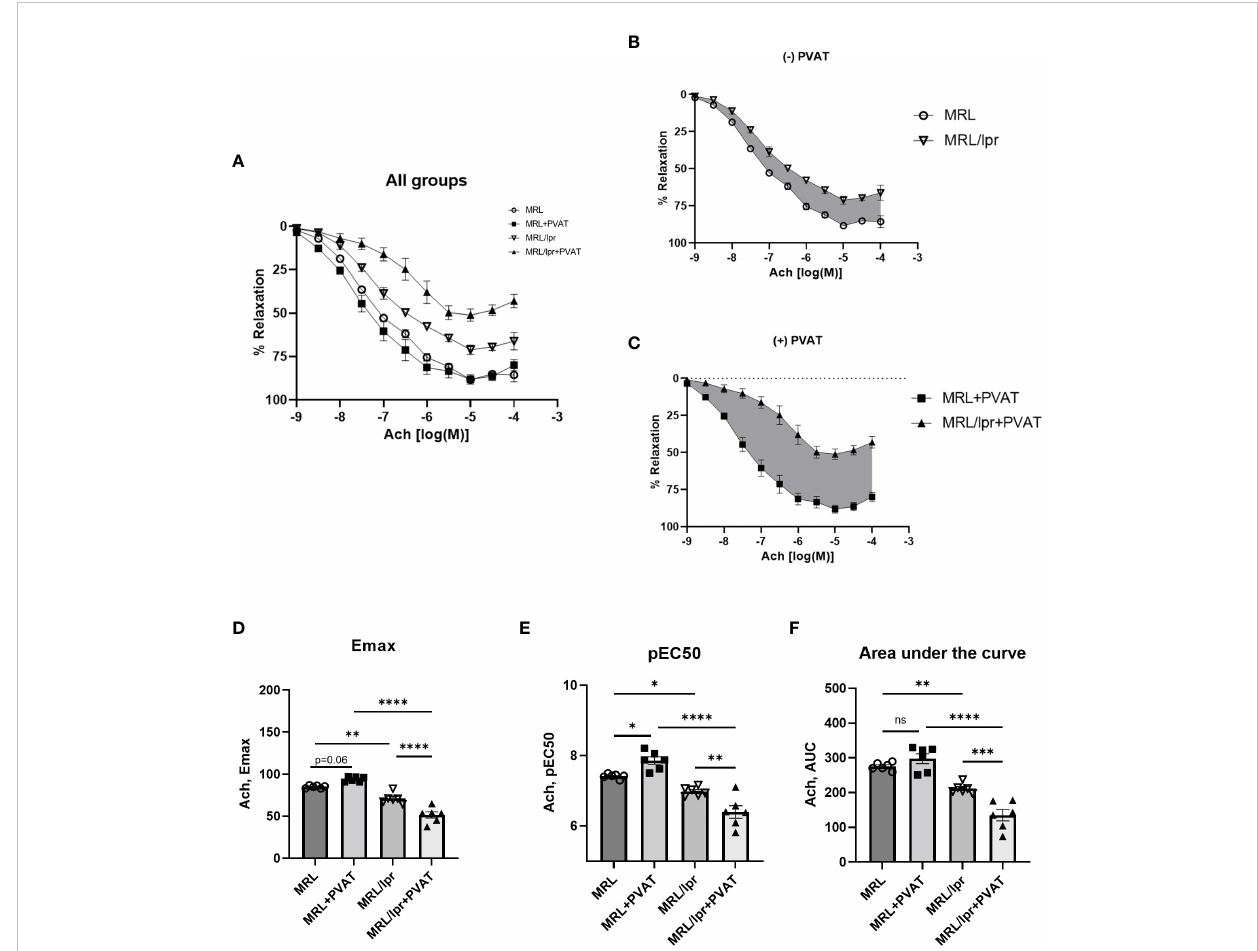
FIGURE 4 MRL/lpr mice exhibited impaired endothelium-dependent relaxation, which was exacerbated by PVAT. (A) Concentration-response curves to Ach in all groups. (B) Concentration-response curves to Ach in the absence of PVAT. (C) Concentration-response curves to Ach in the presence of PVAT. Gray shaded areas indicate reductions in Ach-induced relaxation in MRL/lpr mice. (D) Maximum responses (Emax) to Ach from all concentration-response curves. (E) Negative logarithm of EC50 (pEC50) for all concentration-response curves. (F) Area under the curve (AUC) for all concentration-response curves. *p < 0.05, **p < 0.01, ***p < 0.001, ****p < 0.0001. Ach, acetylcholine; PVAT, perivascular adipose tissue. ns, not signi fi